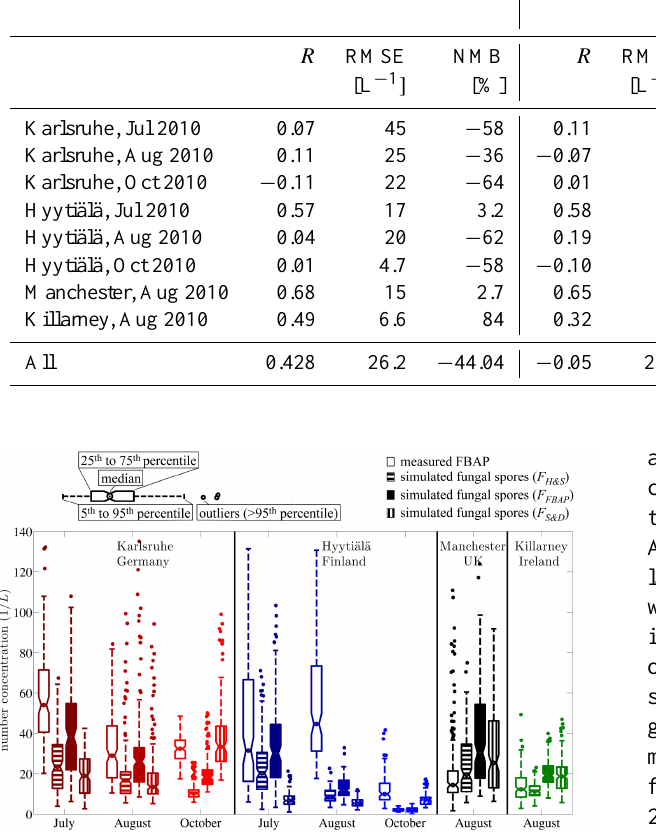
Table 2. Correlation coefficient ( R ), root mean square error (RMSE), and normalized mean bias (NMB) for correlations between simulated fungal spore/FBAP and measured FBAP concentrations at different locations and three different time periods. N H&S N S&D N FBAP Confidence intervals for R